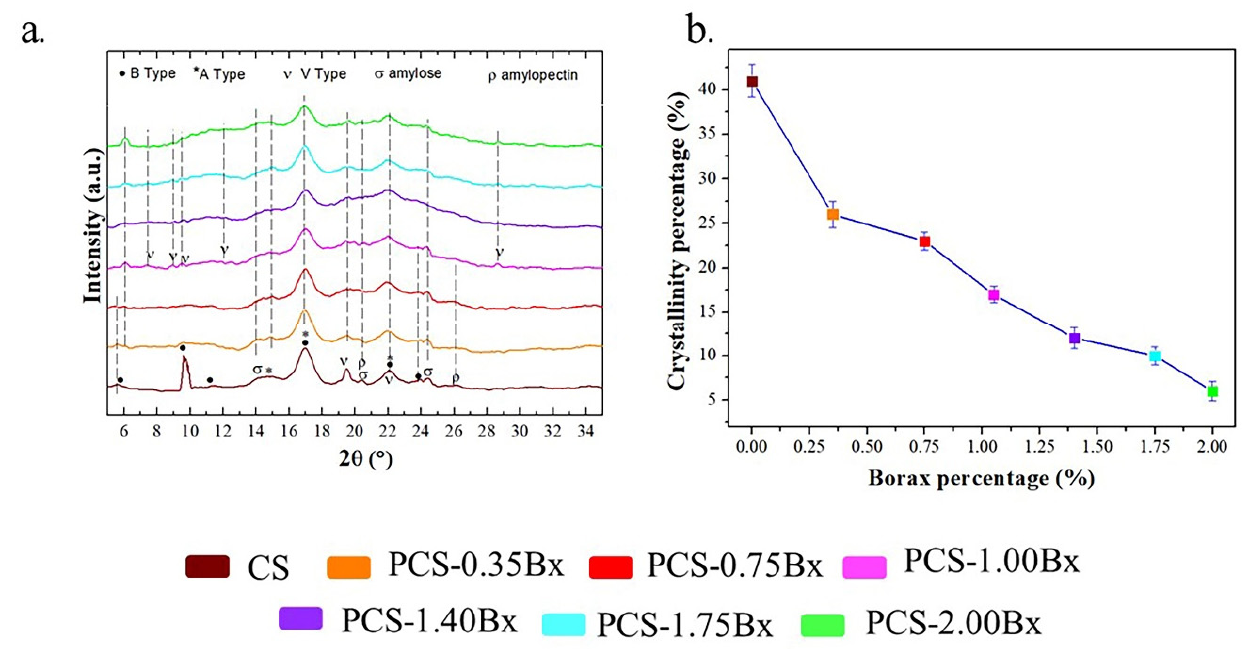
Figure 2. ( a ). X-ray samples’ diffractograms used to calculate the crystallinity percentage showed in ( b